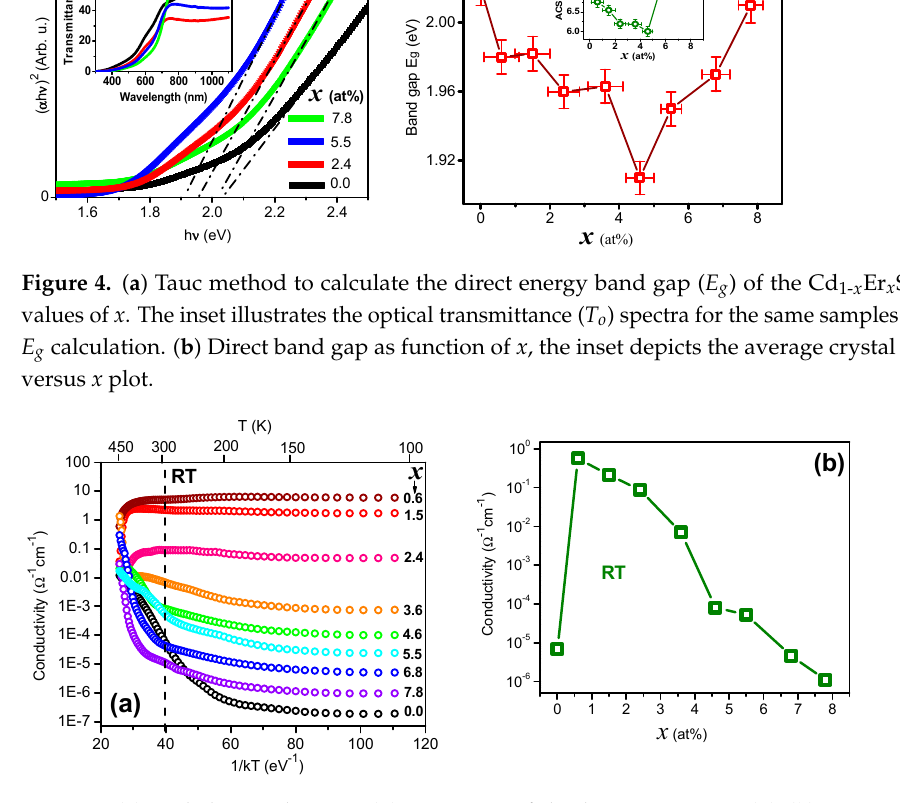
Figure 5. ( a ) Dark d.c. conductivity ( σ ) vs. inverse of absolute temperature (T). ( b ) Room temperature (RT) dark d.c. conductivity σ as a function of x .